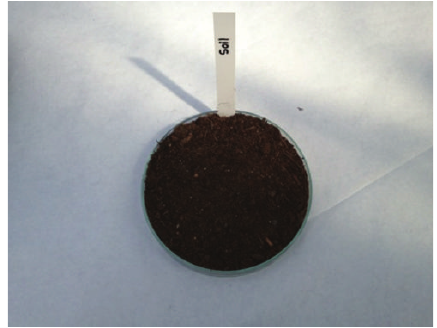
Figure 2: Soil used for the pot experiment.